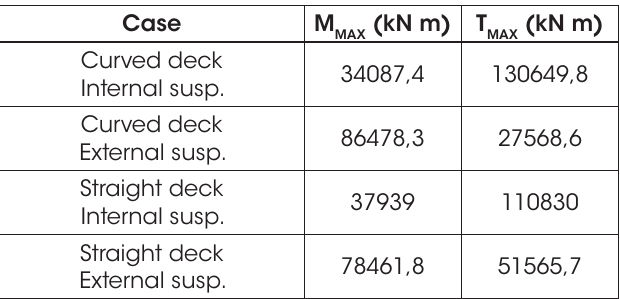
Comparison of results